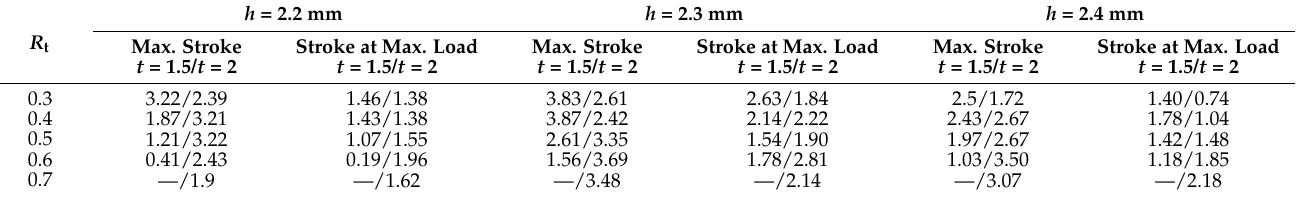
Table 1. Maximum strokes and strokes at maximum load in shear tests (units in mm).